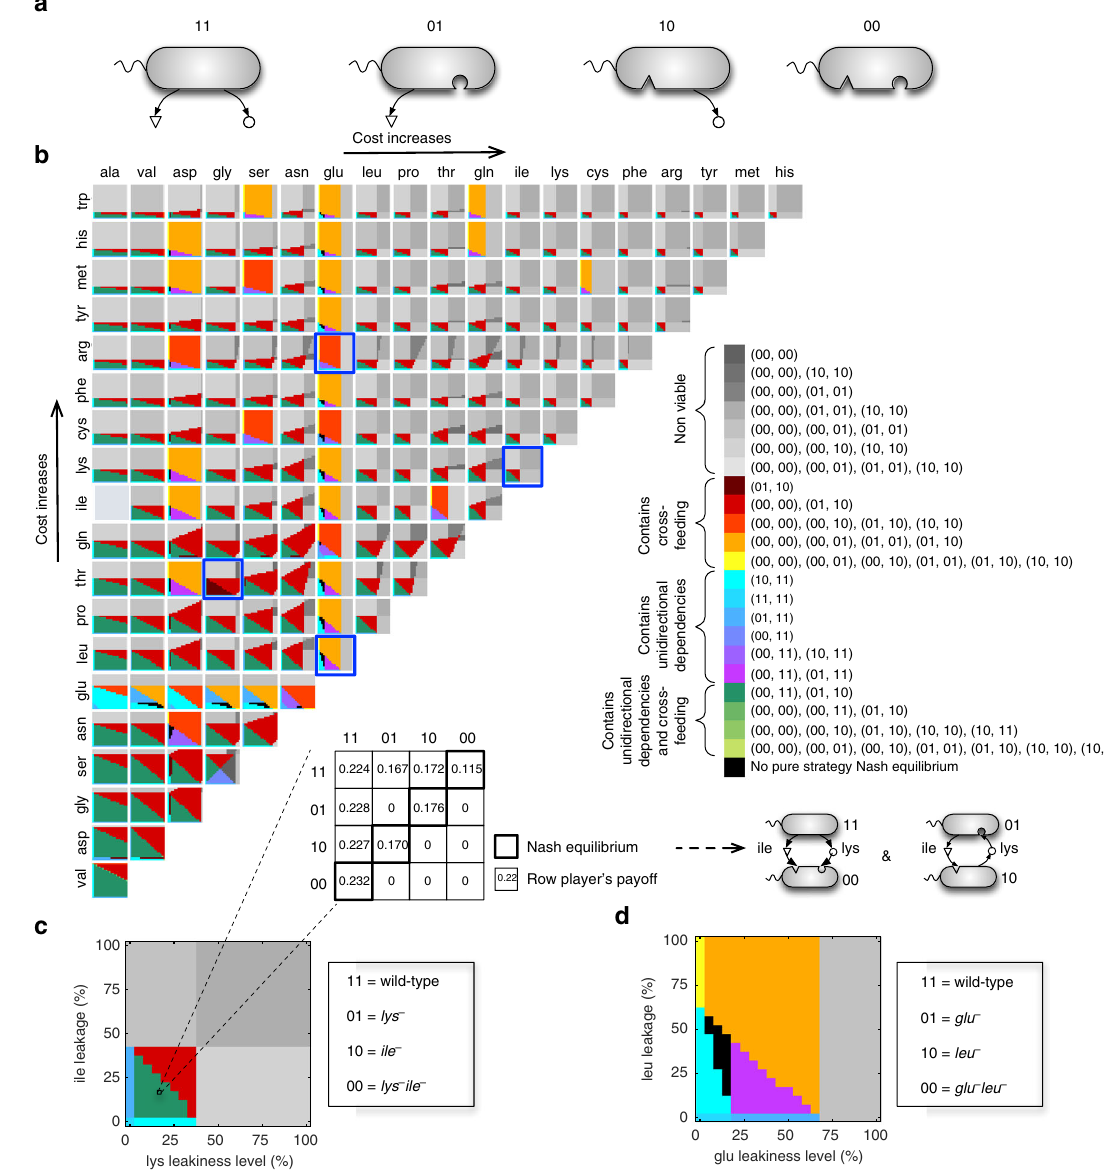
Fig. 4 Equilibrium metabolic dependencies in populations of E. coli with two leaky amino acids. a Genotypes involved include a prototrophic strain self- synthesizing two leaky amino acids (i.e., 11), two single-mutant strains each is auxotrophic for one amino acid but synthesizing and leaking the other (i.e., 01 and 10), and a mutant strain auxotrophic for both leaky amino acids (i.e., 00). Here, “ 1 ” and “ 0 ” denote the presence or absence of biosynthesis pathways (genes) for an amino acid, respectively. b The identi fi ed Nash equilibria of two-player games (i.e., pairwise interactions) for all amino acid pairs across different leakiness levels, zoomed in for two selected pairs including c lysine and isoleucine, d glutamate and leucine. A sample payoff matrix of the game is shown in c for a leakiness level of 15% for both lysine and isoleucine. Non-viable equilibria signify associations between genotypes that are non- viable leading to community collapse. Nash equilibria of three- and four-player games for a selected number of amino acid pairs are also given in Supplementary Figs. 2 –